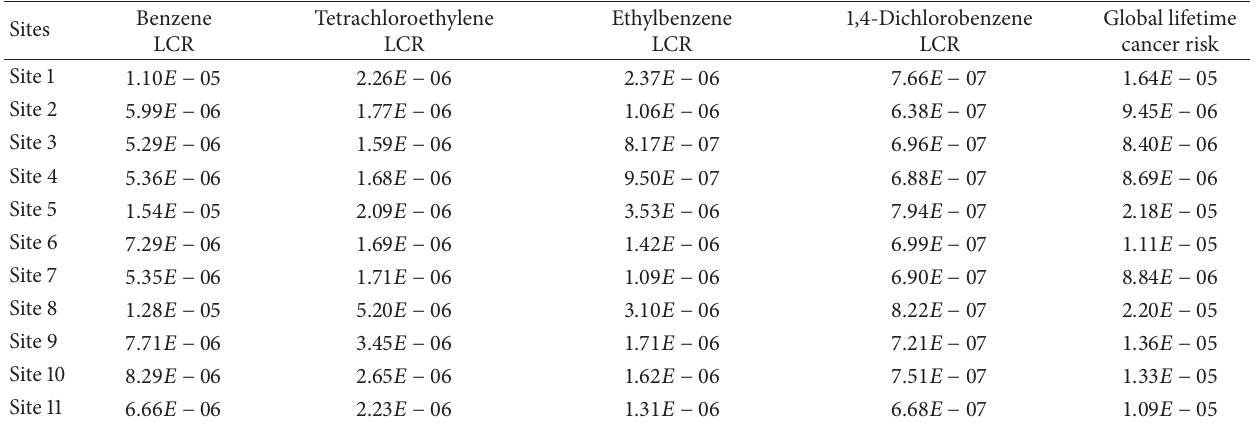
Table 6: The lifetime cancer risk (LCR) of each compound and the global lifetime cancer risk in each investigated site. Benzene Sites